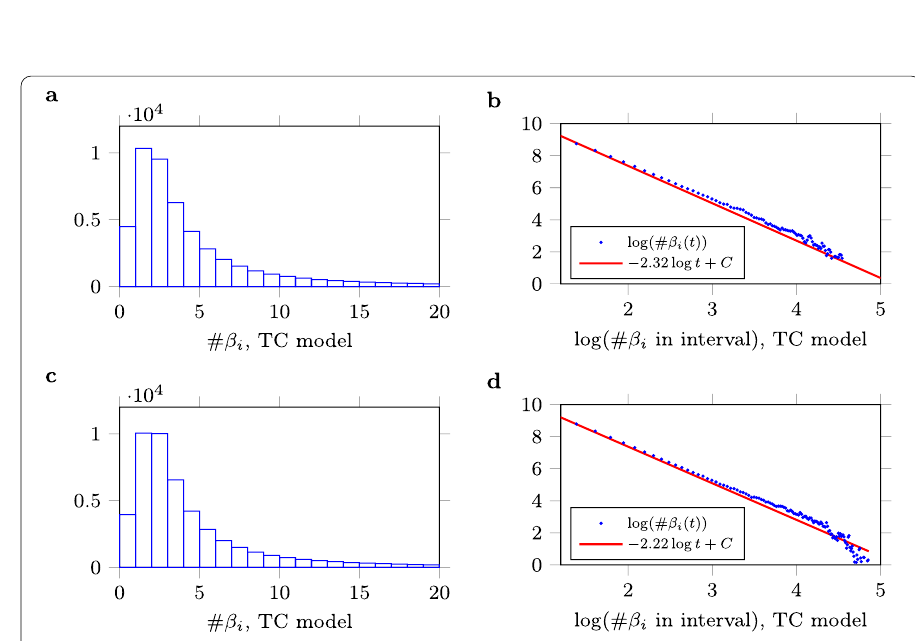
Fig. 20 Plots a and b are obtained by simulation of the Barabási–Albert model with m = 3 , and plots c and d are obtained by simulation of TC with m = 3, p =